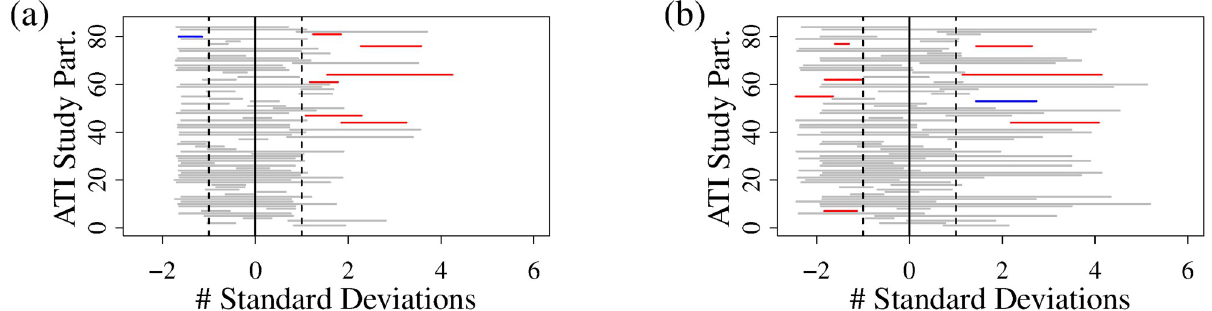
Fig 6. Visualization of model predictions. Visualization of model predictions (a) neglecting pre-ATI ART regimen, using Eq (1), and (b) accounting for pre-ATI ART regimen, using Eq (2). The normalized times of last undetectable measurement and first detectable measurement are shown as line segments spanning the detection window per ATI study participant. Each detection window’s line segment is normalized by subtracting the associated model-predicted mean and dividing by the model-predicted standard deviation. Red and blue lines indicate detection windows that lie wholly outside one standard deviation, with color indicating whether the pre-ATI ART regimen is included (red) or excluded (blue) NNRTIs, while grey lines indicate detection windows that may be within one standard deviation of the